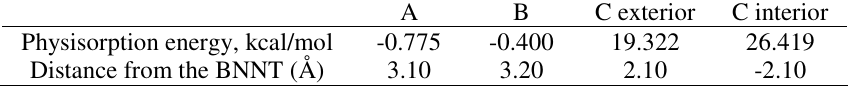
Figure 2. Interaction energy curves of an O molecule physisorbed on the (5, 5) BNNT, 2 obtained by the SPE calculation in which the O=O and all the B-N bond lengths are kept frozen and only the distance between the molecule and the nanotube axis is varied. Table 1. Physisorption energy (kcal/mol) and equilibrium distance (Å) (rd) of an O 2 molecule on the (5, 5) BNNT.